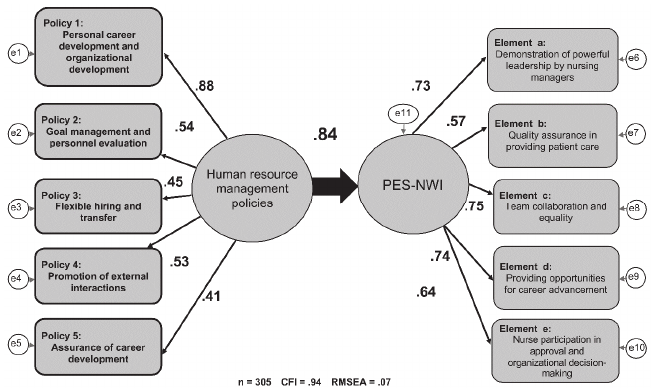
Fig. 2. Causal model of HRM policies and PES-NWI. HRM = human resource management; PES-NWI = Prac- tice Environment Scale of the Nursing Work Index; RMSEA = root mean square error of approximation.